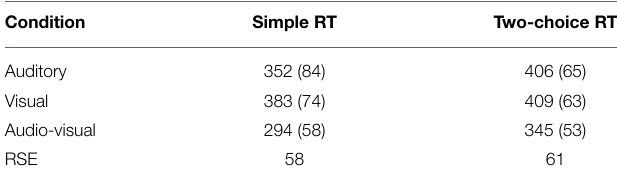
TABLE 2 | Mean Response Times and RSEs (standard deviations in parentheses) for unimodal (auditory, visual) and bimodal (audio-visual) stimulus conditions in the simple RT Experiment 1 and the two-choice RT Experiment